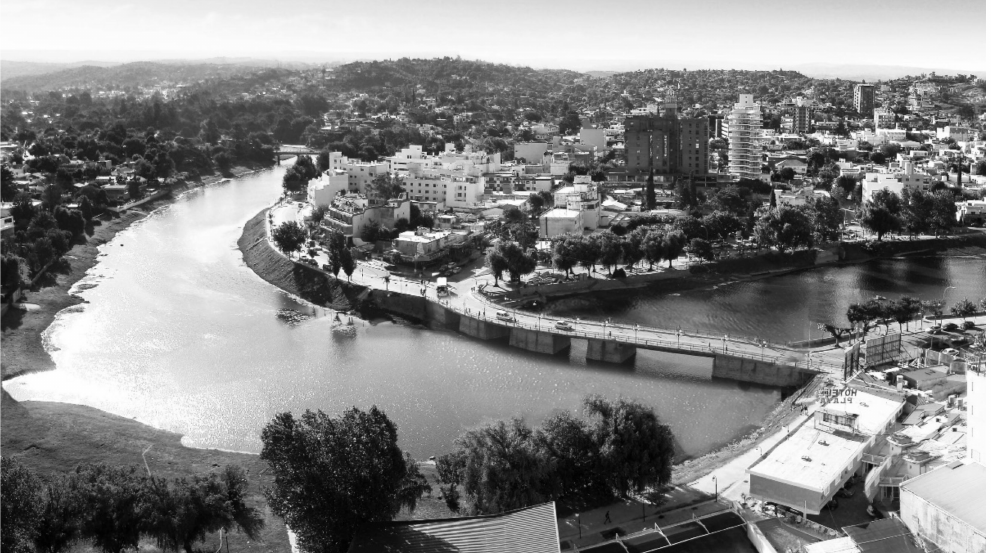
Figure 3. Aerial view taken from the east precinct, showing the San Antonio River and the 1889 bridge. Mixed-use, mostly retail and residential, occurs in low to medium